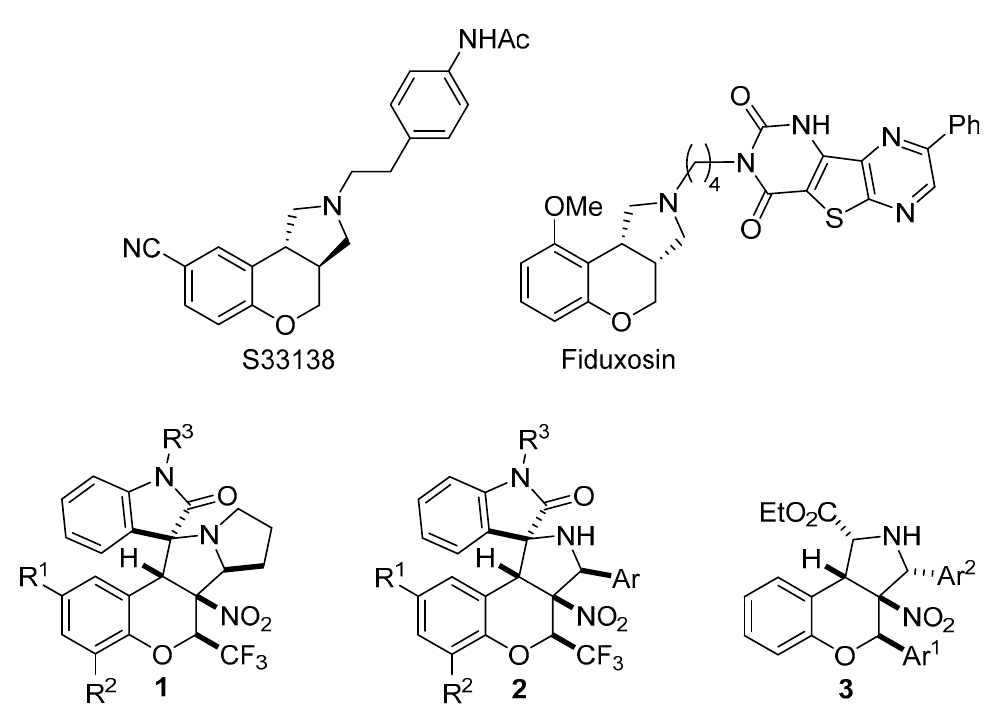
Figure 1. Some bioactive chromenopyrroli(zi)dines.